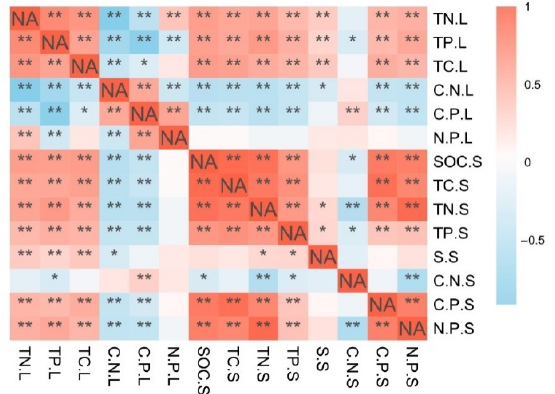
Figure 4. Correlation coefficients between leaf carbon (C), nitrogen (N), and phosphorous (P) stoichiometric characteristics and soil characteristics (C, N, P stoichiometry, organic C, salinity). TC.L: total soil C content; TN.L: total N content of leaves; TP.L: total P content of leaves; C/N.L: leaf C/N ratio; C/P.L: leaf C/P ratio; N/P.L: leaf N/P ratio; SOC.S: soil organic C content; TC.S: soil total C content; TN.S: soil total N content; TP.S: soil total P content; S.S: soil salinity; C/N.S: soil C/N ratio; C/P.S: soil C/P ratio; N/P.S: soil N/P ratio; * indicates p < 0.05, ** indicates p < 0.01, *** indicates p < 0.001.